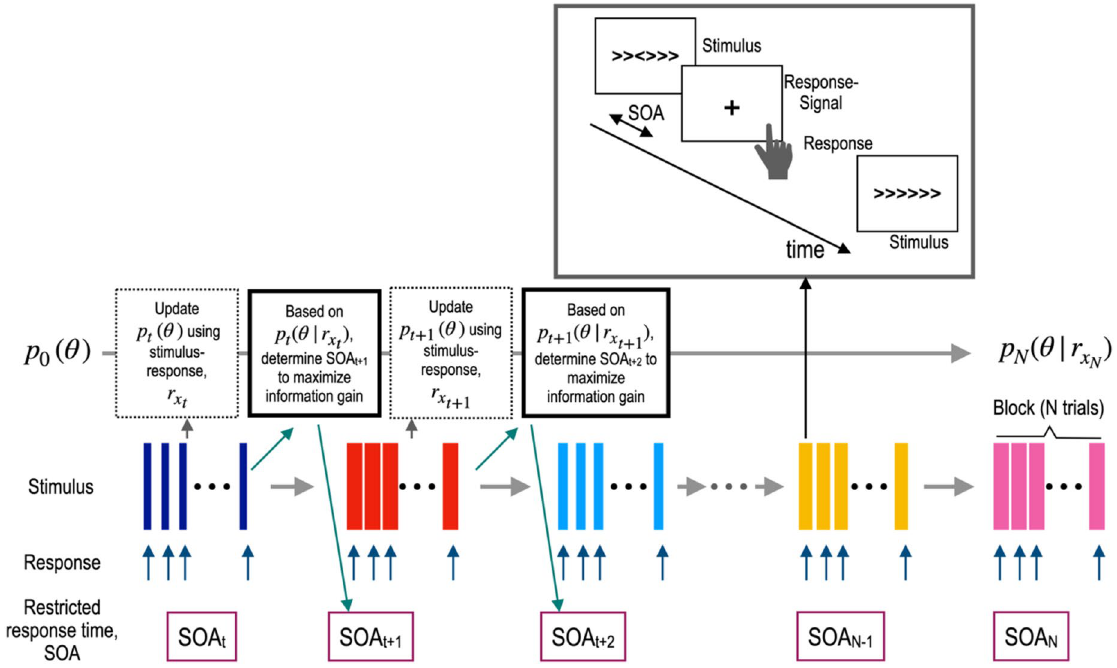
Figure 2. The overall procedure of the Bayesian adaptive estimation for SAT function. From a prior p 0 (θ) , model parameter θ is estimated in a Bayesian update rule. After the t-th trial, the prior distribution p t (θ) at the t-th trial is updated to the posterior distribution p t (θ | r x ) with the observer’s binarized response r x (correct or incorrect) for a stimulus with an RT x by Bayes rule. See Method section for